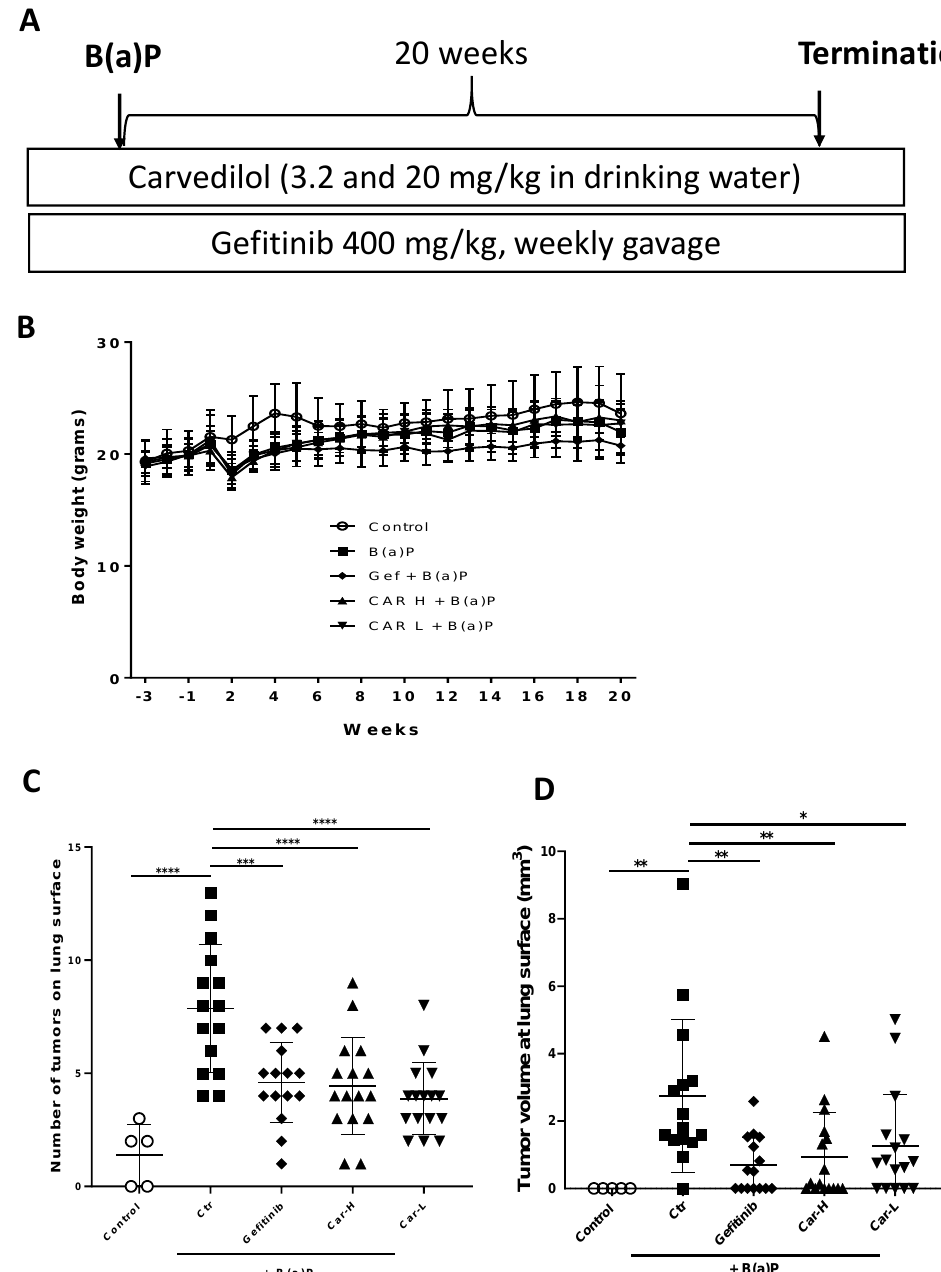
Figure 4. Effects of carvedilol on B(a)P-induced lung carcinogenesis. ( A ) Experimental design. The A/J mice were divided into five groups: (1) negative control group without B(a)P exposure (n = 5); (2) B(a)P-only group (n = 17); (3) B(a)P and treated with gefitinib (n = 16); (4) B(a)P and treated with 3.2 mg/kg carvedilol (n = 16); and (5) B(a)P and treated with 20 mg/kg carvedilol (n = 16). The drug treatment started three weeks before the B(a)P exposure. The dose of gefitinib was 400 mg/kg, given